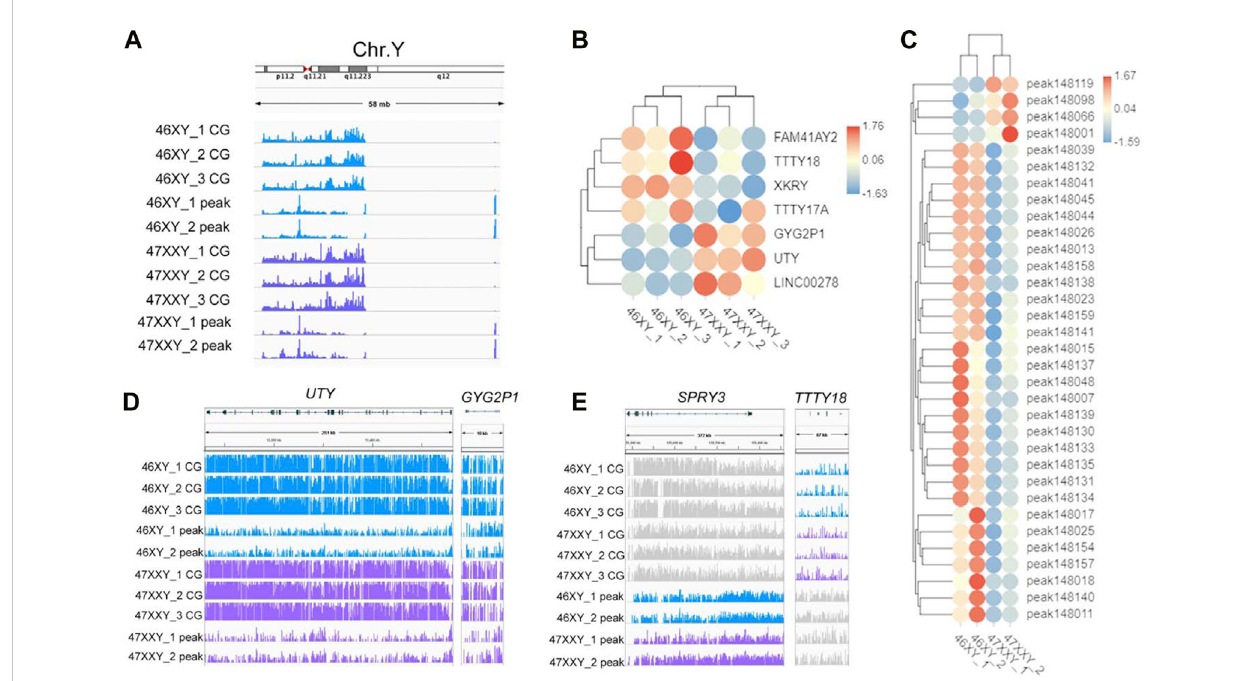
FIGURE 5 Themethylationlevel andchromatinaccessibility oftheChr.Y (A) IGVmapofChr.Y (58 Mb) intwoseries data(WGBSand ATAC-seq) from46XYand 47XXY groups. The blue channel represents the 46XY, and the purple channel represents the 47XXY, and the 46XX has a little signal. (B) Heatmap of the methylation level in Chr.Y. Each circle represents the normalized methylation level in each sample in 46XY and 47XXY. The colors from red, white to blue mean the methylation levels from 1.76, 0.06 to − 1.63. (C) Heatmap of the chromatin accessibility in Chr.Y. Each circle represents the normalized chromatin open level in each sample in 46XY and 47XXY. The colors from red, white to blue mean the methylation levels from from high, median to low (1.67, 0.03 to − 1.59). (D) IGV map of UTY and CYG2P1 gene. (E) IGV map of SPRY3 and TTTY18